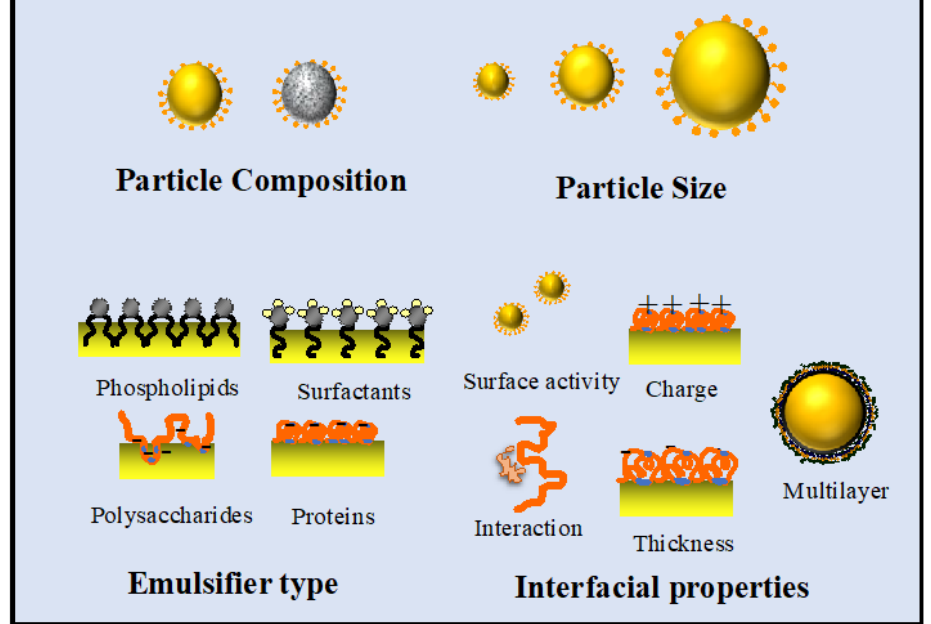
Figure 4. Some critical factors that determine the functional performance of nanoemulsion delivery systems.